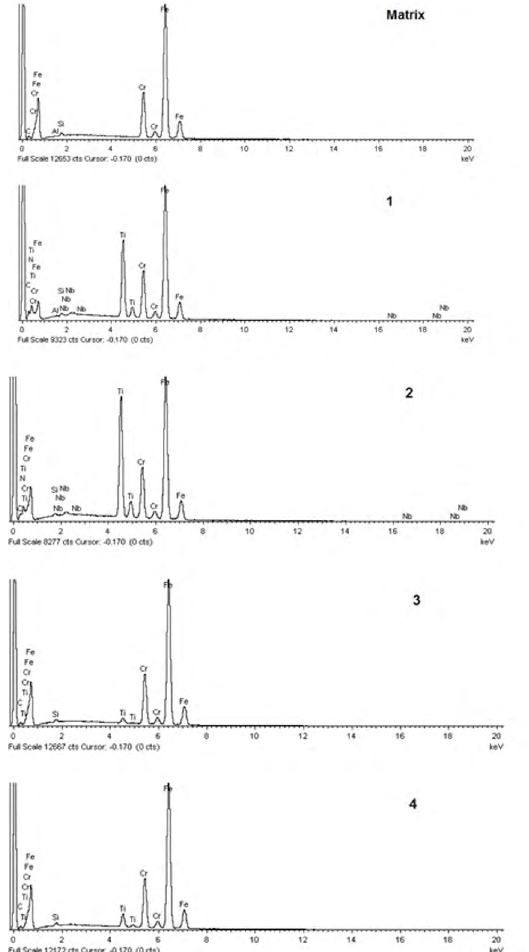
Figure 3. EDS spectra of matrix and precipitates of the AISI 409 stainless steel sample. The spectra are referred to the regions identified in Fig. 2b.